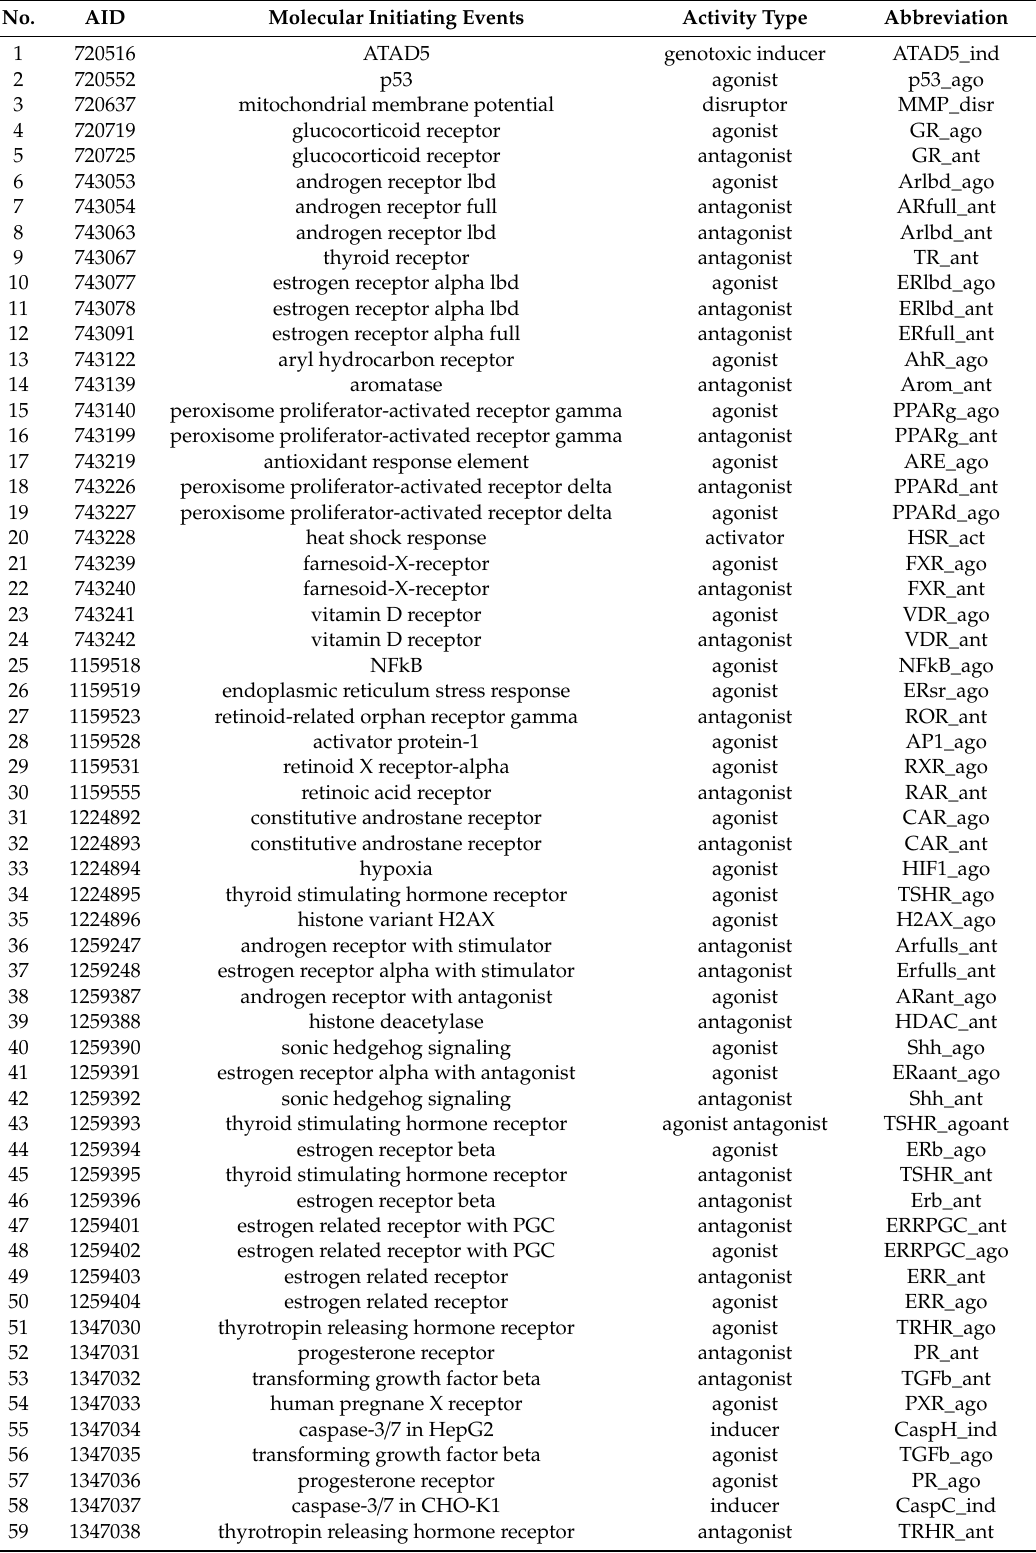
Table 3. Molecular Initiating Events (MIEs) used in this